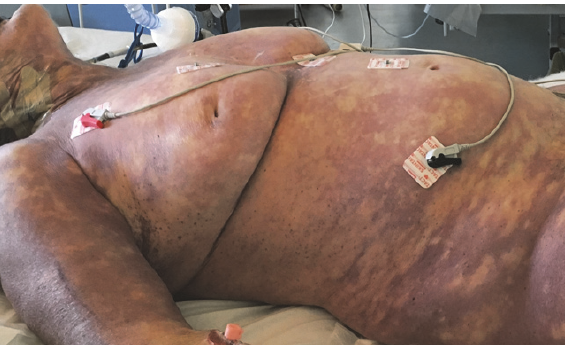
Figure 2: Purpura of trunk and